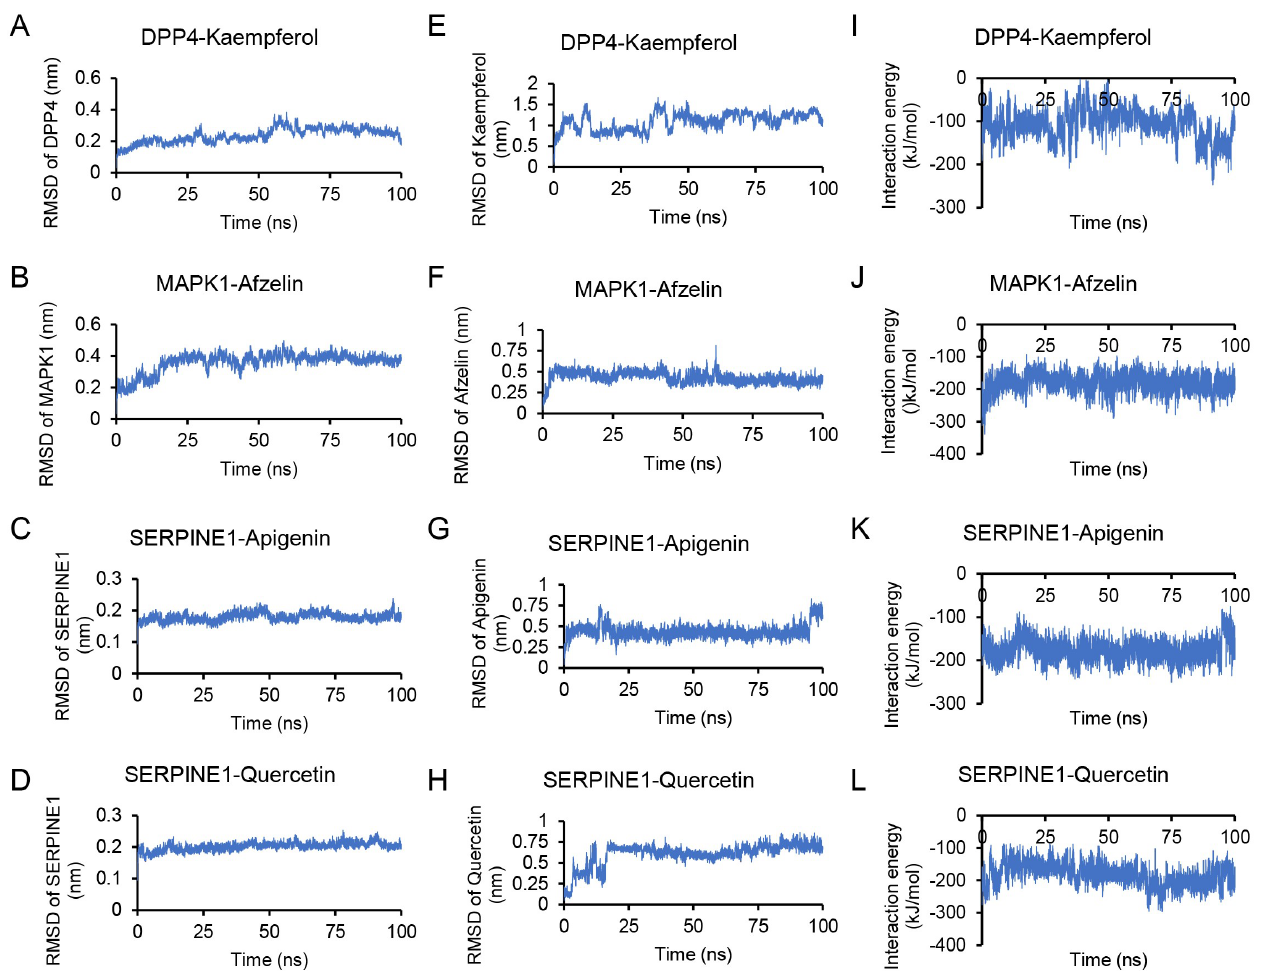
Figure 7. Molecular dynamics simulation results. ( A – C ) Molecular dynamics simulation results of DPP4–kaempferol. Root square deviation (RMSD) of DPP4 skeleton atom ( A ), the RMSD of kaempferol heavy atom ( B ), and the interaction energy between DPP4 and kaempferol during 100 ns